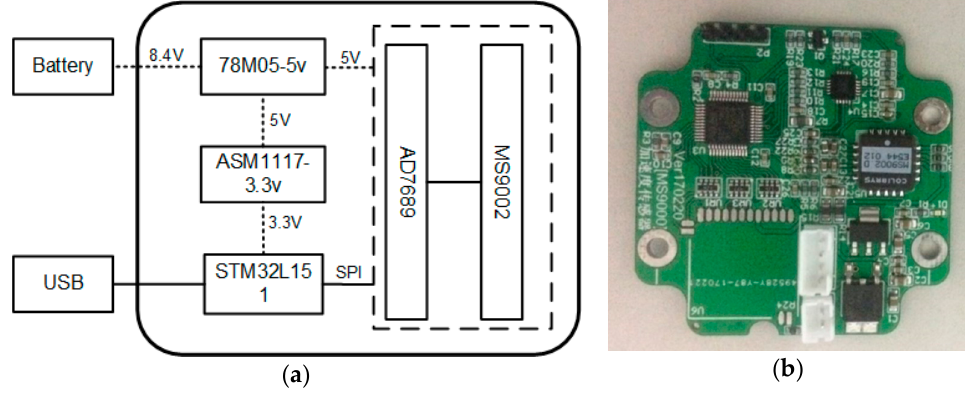
Figure 2. The printed circuit board (PCB) of the acceleration sensing node. ( a ) PCB composition; ( b ) PCB.